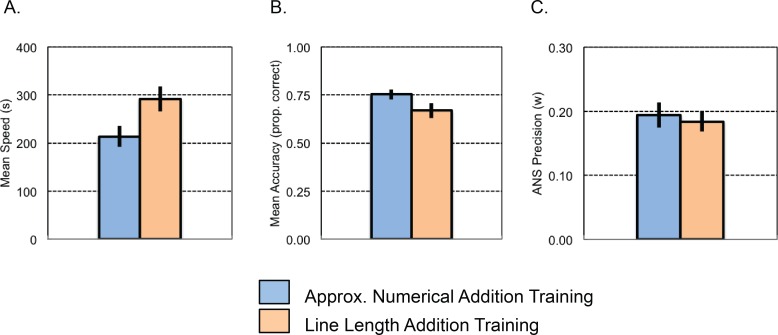
Experiment 1 test results.Average speed (A) and accuracy (B) on exact, symbolic addition problems and approximate numerical comparison performance (C) by children in the two training conditions. Note: Performance accuracy in numerical comparison (C) is represented as a Weber fraction (w) derived from approximate, non-verbal numerical comparison performance, where smaller w values correspond to more precise ANS acuity.